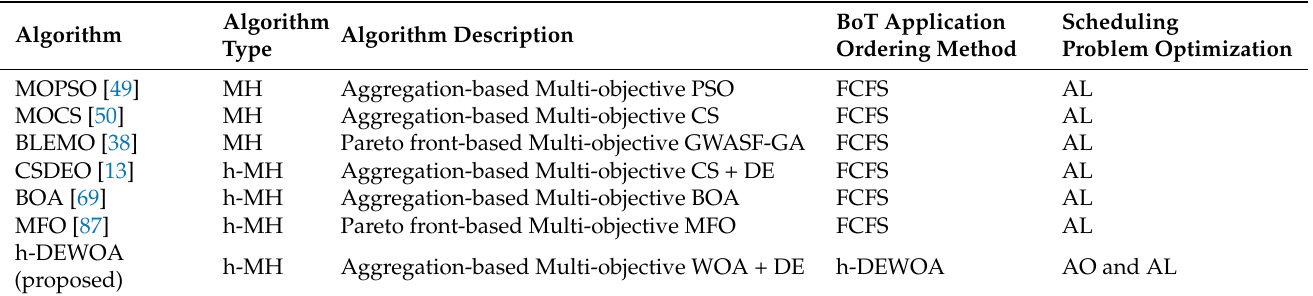
Table 12. Characteristics of tested scheduling algorithms.